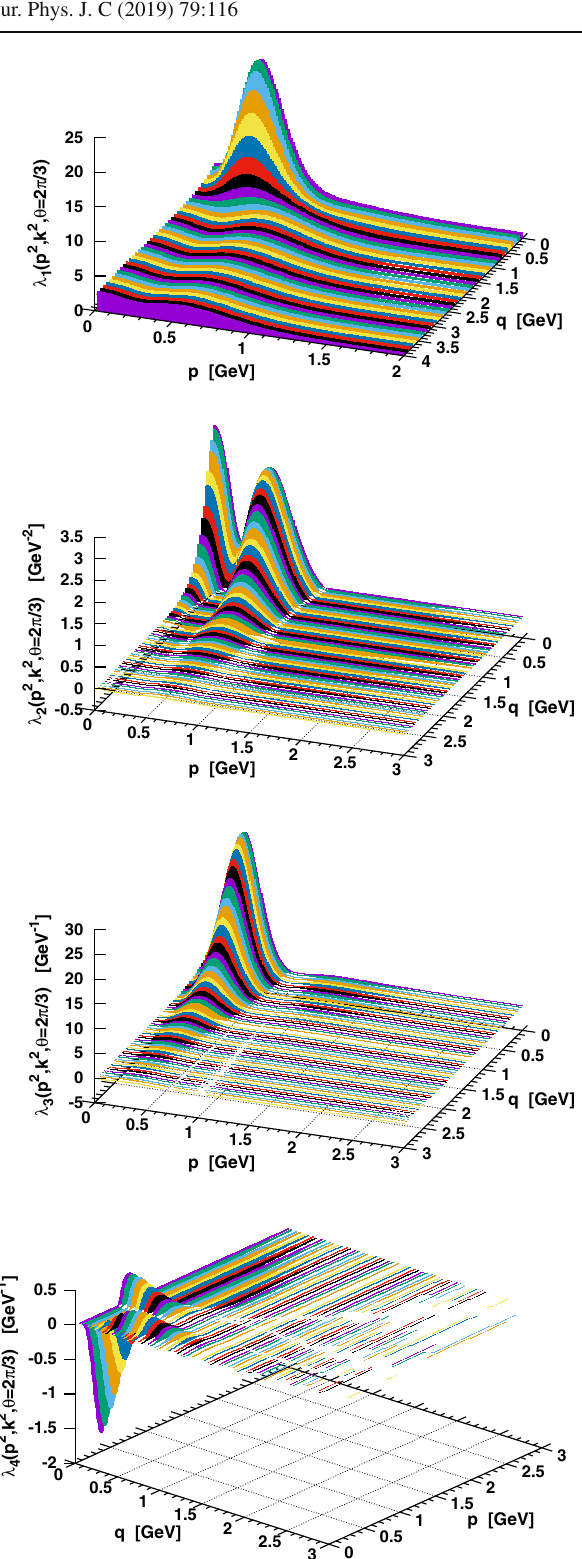
Fig. 37 Longitudinal quark-gluon form factor for θ = 2 π/